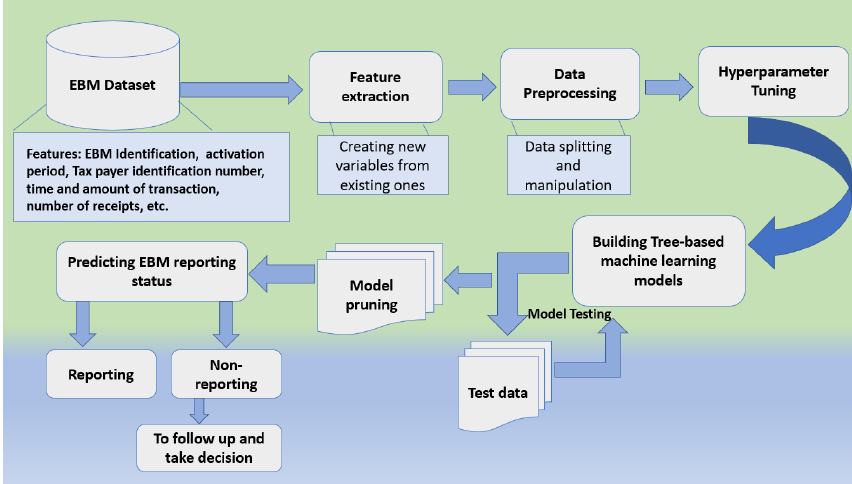
Figure 1. Pipeline of the